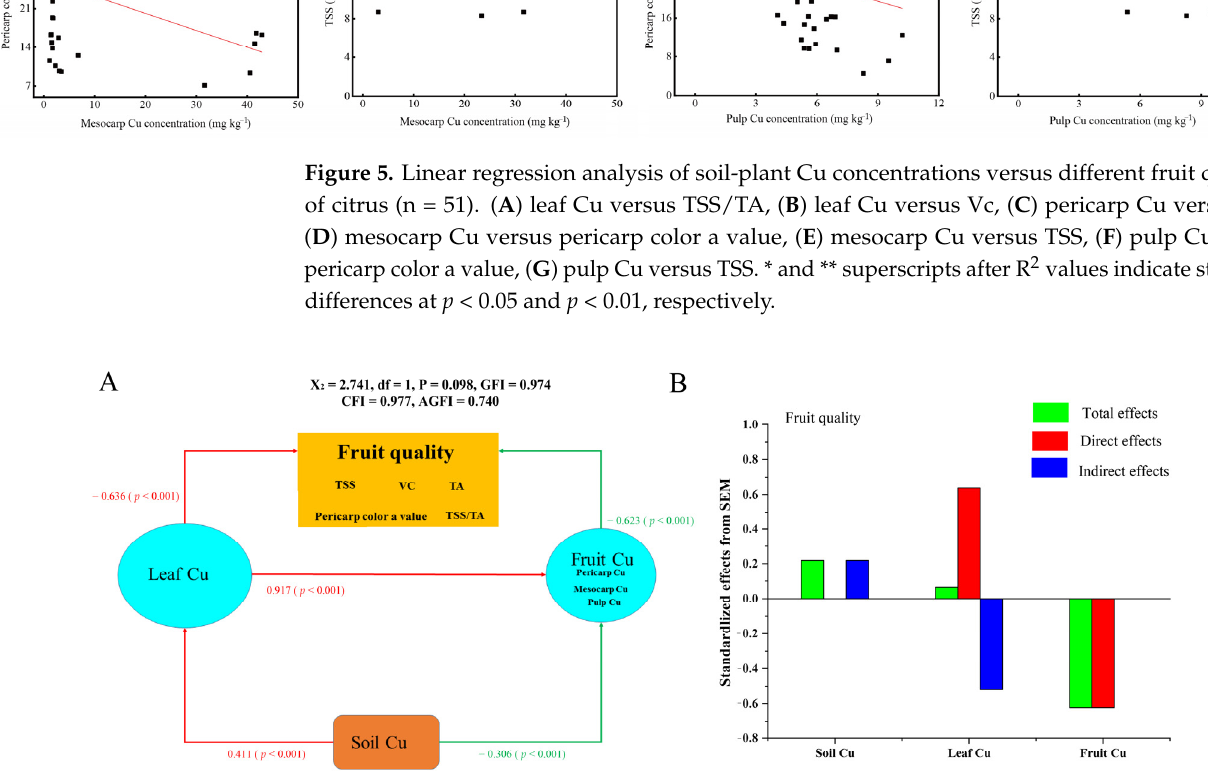
Figure 6. The direct and indirect effects of fruit quality with soil Cu, leaf Cu, and fruit Cu was determined by structural equation modeling (SEM). ( A ) The structural equation modeling diagram. ( B ) The direct and indirect effects of different factors on fruit quality. Positive and negative effects were represented by red and green colors, respectively. The red line indicated a significant positive correlation, the green line indicated a significant negative correlation. p < 0.05 and p < 0.001 denote significant and extreme difference, respectively.